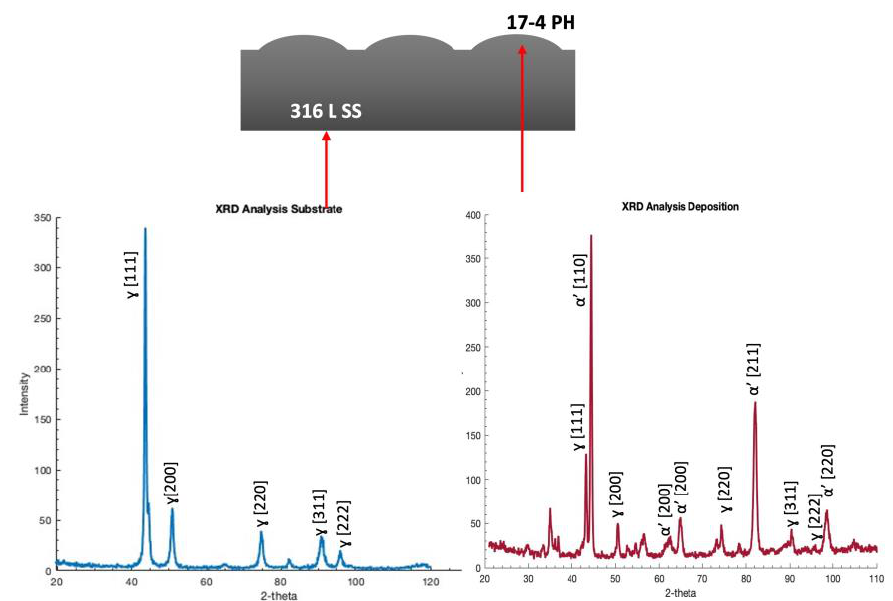
Figure 12. XRD patterns performed on sample S4_A_2.